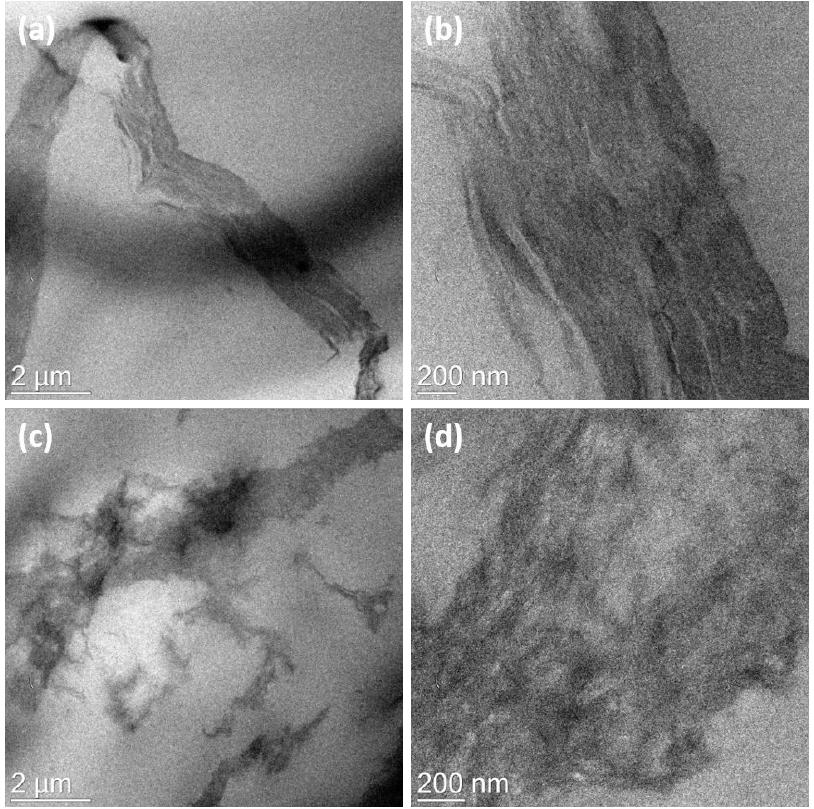
Figure 6. TEM images of the ( a , b ) SBR/GO and ( c , d ) SBR/rGO – SH.